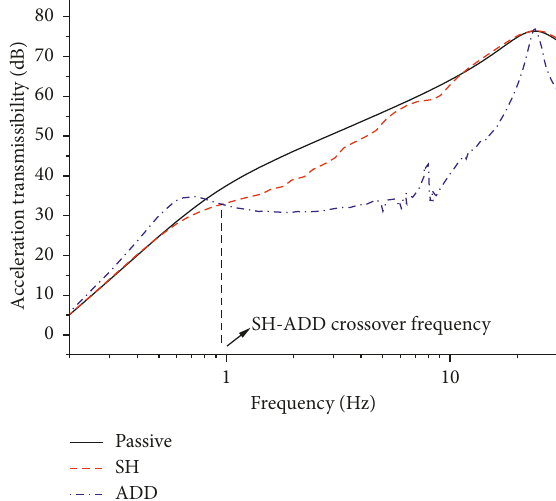
Figure 8: Comparison of transmissibility of several control strategies.